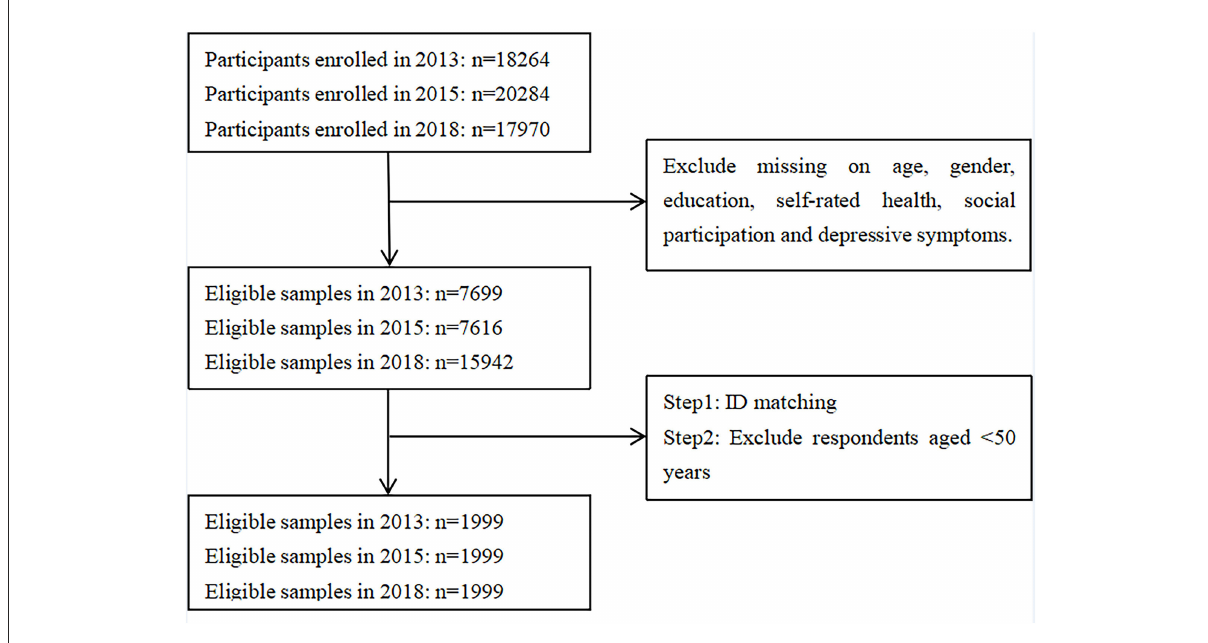
FIGURE1 Flowchart of participant